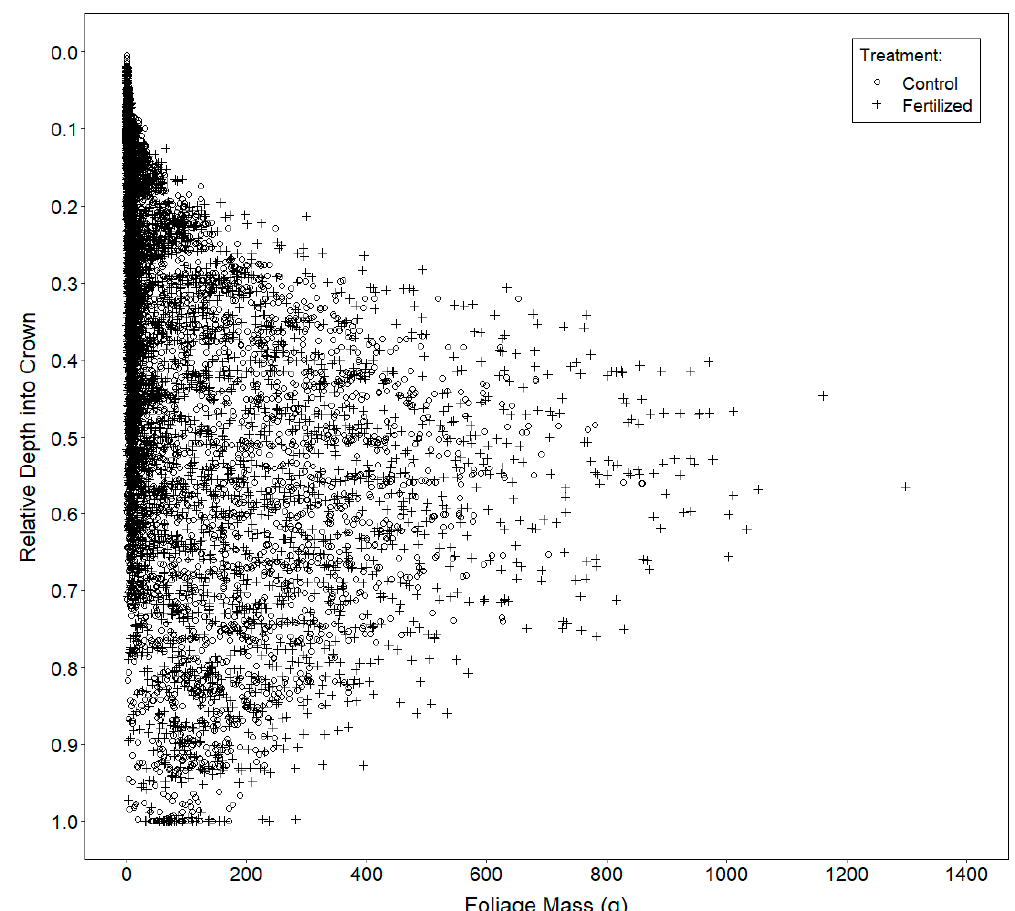
Figure 3. Trend in branch-level foliage mass (g) over relative depth into crown (RDINC) as predicted by the final model (Equation (9)) for all live branches measured from felled sampled trees. RDINC = 1 at crown base and RDINC = 0 at tree tip.